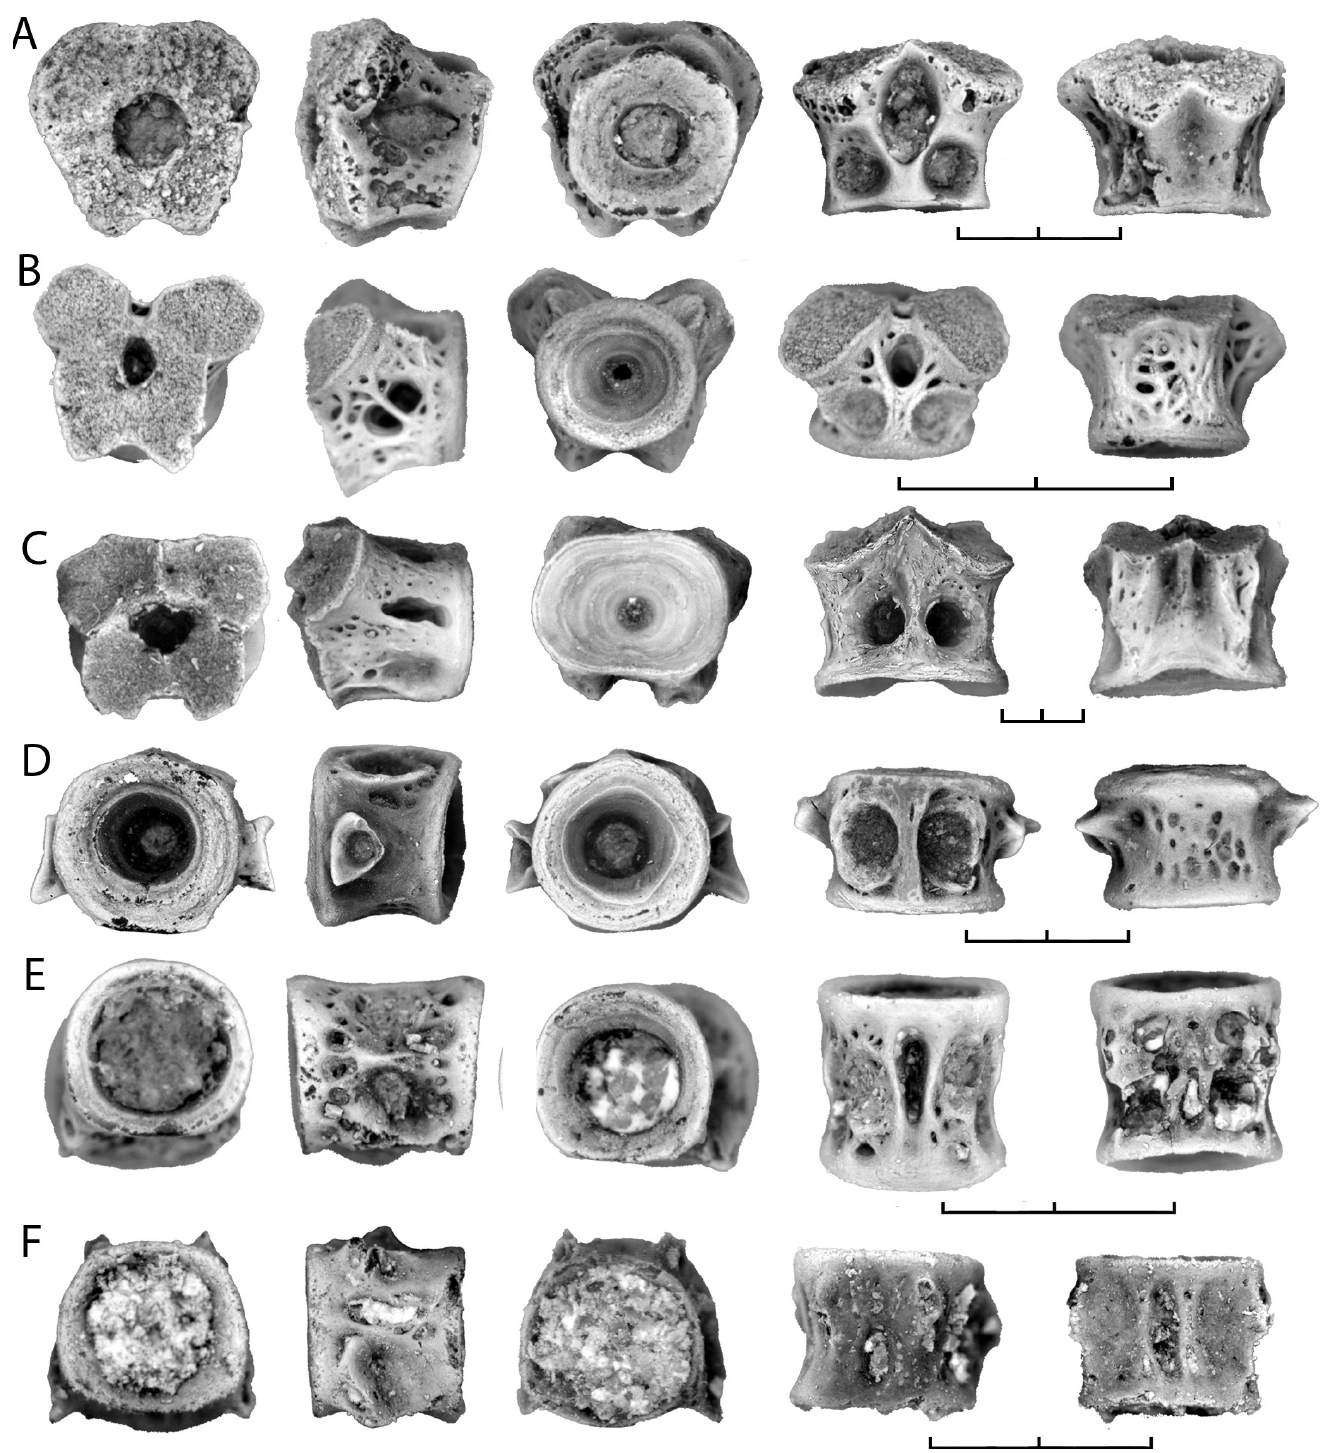
Figure 14. Centra of Hiodontidae gen. indet. from the Milk River Formation compared with specimens from the late Campanian of Alberta, and extant Hiodon alosoides . A) first centrum from the Milk River Formation, TMP 2000.2.55. B) first centrum from the Dinosaur Park Formation, TMP 2005.12.569. C) first centrum of Hiodon alosoides , specimen TMP 90.7.832. D) anterior precaudal centrum, from the Milk River Formation, UALVP 17397. E) mid-precaudal centrum from the Milk River Formation, UALVP 48881. F) posterior precaudal centrum from the Milk River Formation, UALVP 48880. Centra shown in anterior, left lateral, posterior, dorsal and ventral views. Scale bar equals 2